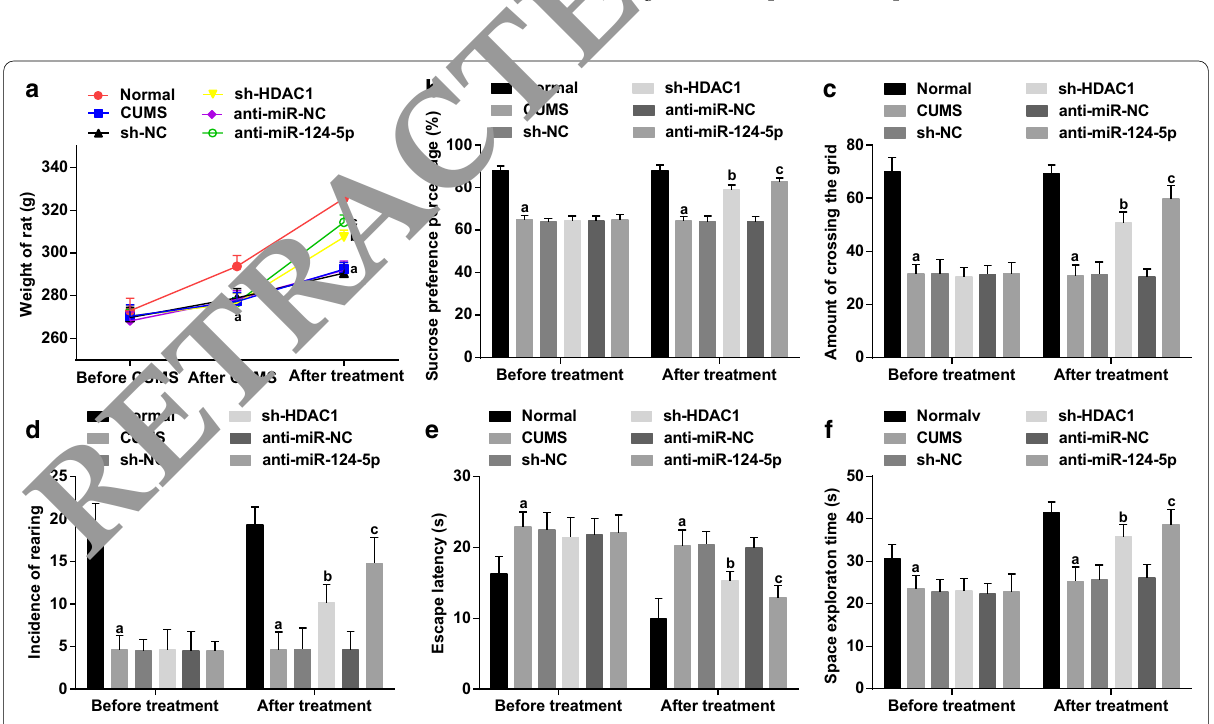
Fig. 2 Inhibition of either HDAC1 or miR-124-5p increases weight and improves learning and memory abilities of depressed rats. a Effects of inhibition with HDAC1 or miR-124-5p on the body weight of depressed rats; b SPP before and after inhibition with HDAC1 or miR-124-5p; c Frequency of crossing the gird in OFT before and after inhibition with HDAC1 or miR-124-5p; d Incidence of rearing in OFT before and after inhibition with HDAC1 or miR-124-5p; e Escape latency in MWM test before and after inhibition with HDAC1 or miR-124-5p; f Space exploration time in MWM test before and after inhibition with HDAC1 or miR-124-5p; n 10; a P < 0.05 compared with the normal group; b P < 0.05 compared = with the sh-NC group; c P < 0.05 compared with the anti-miR-NC group. Comparisons among multiple groups were evaluated by one-way ANOVA, and pairwise comparisons by Tukey’s post hoc